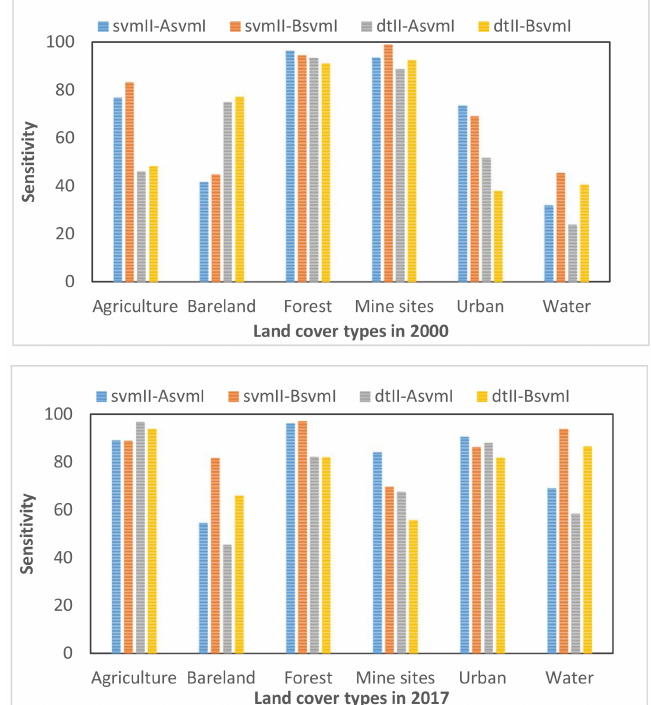
Figure 3. The sensitivity of each land cover types in classification method II results against with 2000 and 2017 A_svmI and B_svmI